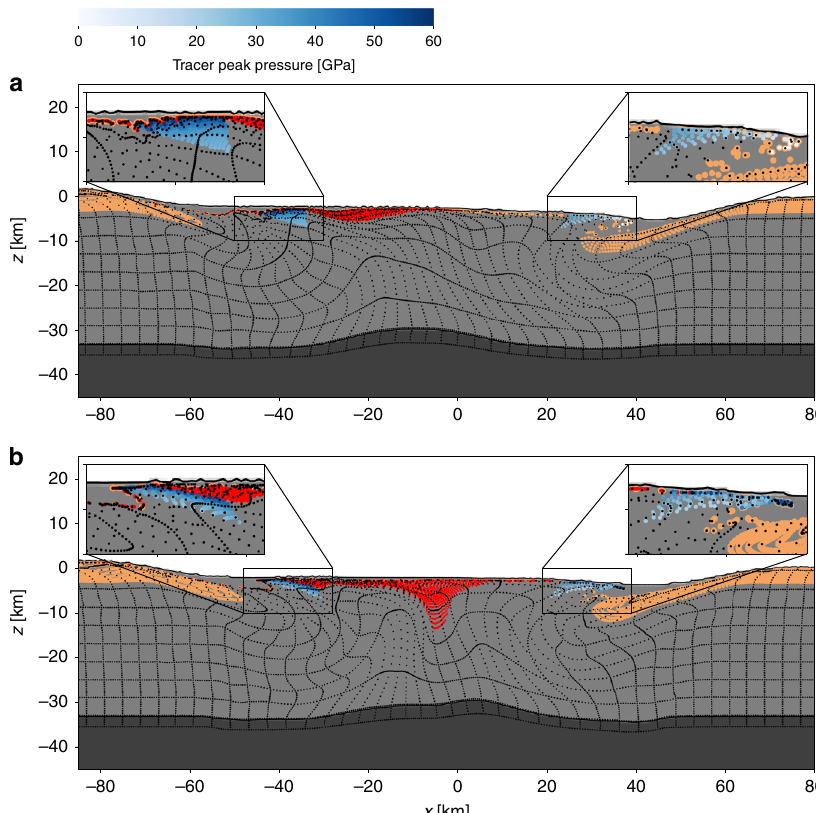
Fig. 4 Final simulated Chicxulub crater for a 30 (cid:1) and 60 (cid:1) impact angle. Shown are cross-sections, along the plane of trajectory, through the fi nal simulated craters formed by a 30 (cid:1) ( a ) and 60 (cid:1) ( b ) impact, with x ¼ 0 de fi ned at the crater centre (measured at the pre-impact level); the direction of impact is from right to left. Sandy-brown tracers indicate the fi nal position of the upper 3 km of the pre-impact target (sedimentary rock); red tracers indicate the position of melt; tracers with blue – white shading indicate shock pressures of simulated peak-ring materials. The geometric centre of the crater rim de fi nes the coordinate origin ( x ¼ 0); negative x -values are downrange.